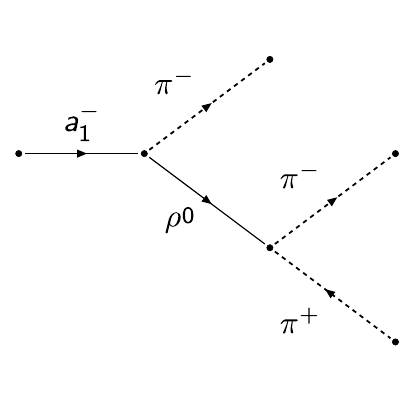
Figure 4 . The decay of a 3pr